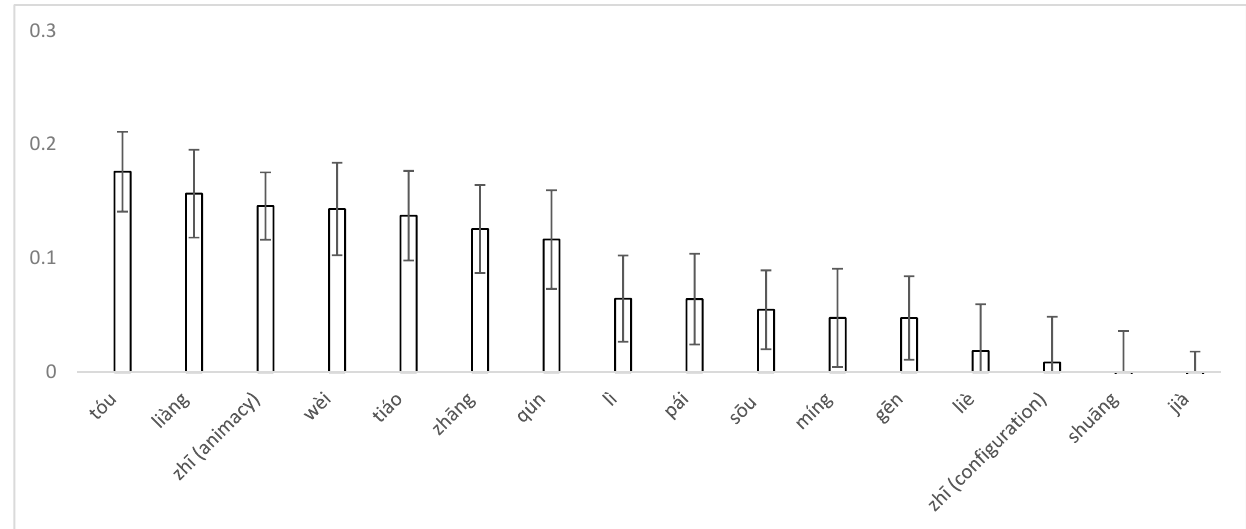
Figure 2. The TF increase for each classifier across all participants. The TF increase significantly exceeded 0 for tóu , liàng , zh ī (animacy), wèi , tiáo , zh ā ng , qún , but not for lì , pái , s ō u , míng , g ē n , liè , zh ī (configuration), shu ā ng , and jià . Error bars reflect SEM. The means (standard deviations) are provided here: tóu : 0.18 (0.29); liàng : 0.16 (0.31); zh ī (animacy): 0.15 (0.25); wèi : 0.14 (0.34); tiáo : 0.14 (0.32); zh ā ng : 0.13 (0.32); qún : 0.12 (0.36); lì : 0.06 (0.31); pái : 0.06 (0.33); s ō u : 0.05 (0.29); míng : 0.05 (0.36); g ē n : 0.05 (0.28); liè : 0.02 (0.33); zh ī (configuration): 0.008 (0.33); shu ā ng : − 0.005 (0.35); jià : − 0.02 (0.31).